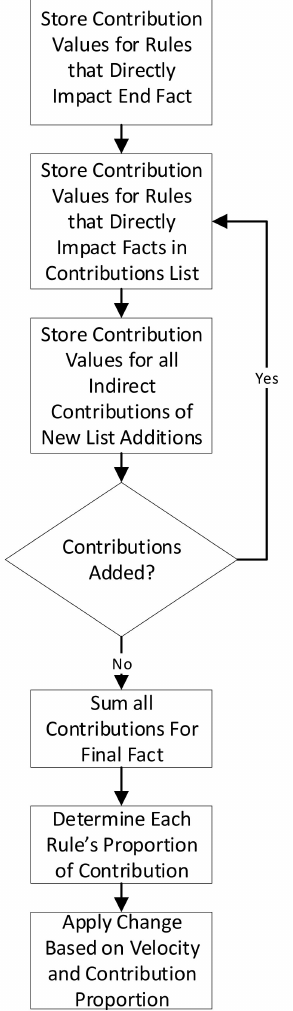
Figure 2. Node Change Determination Algorithm